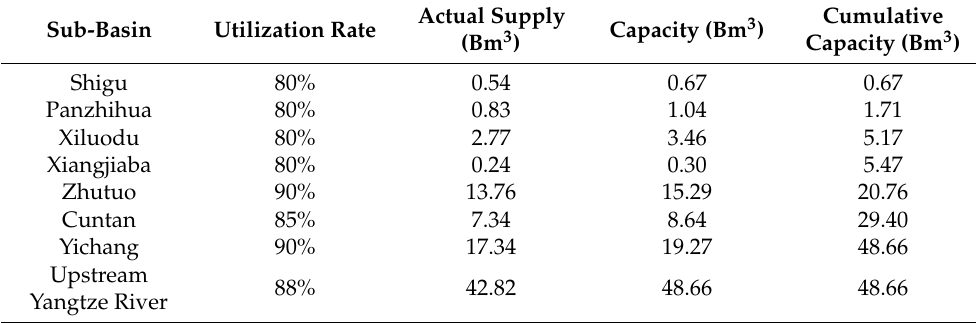
Table 3. Water supply capacity estimation in sub-basins of upstream Yangtze River in